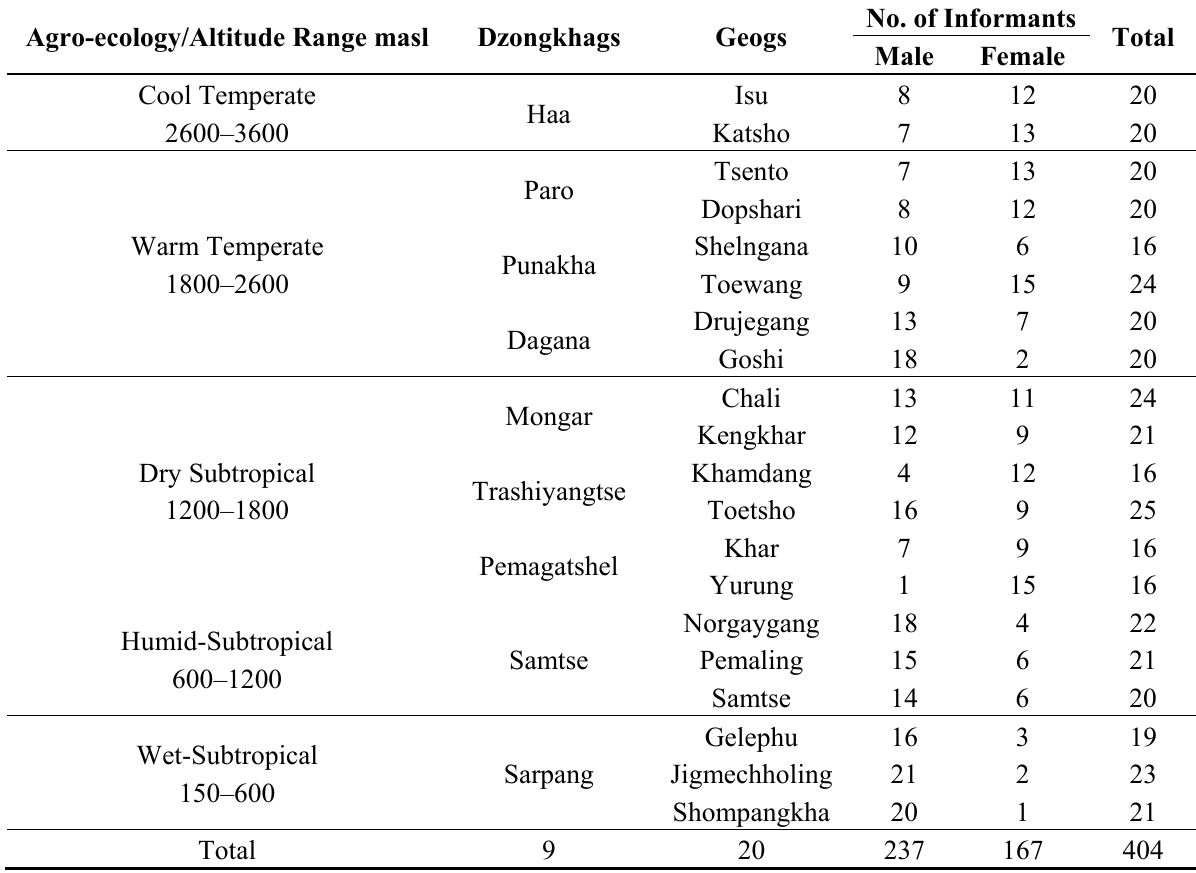
Table 1. Detail of the study sites and